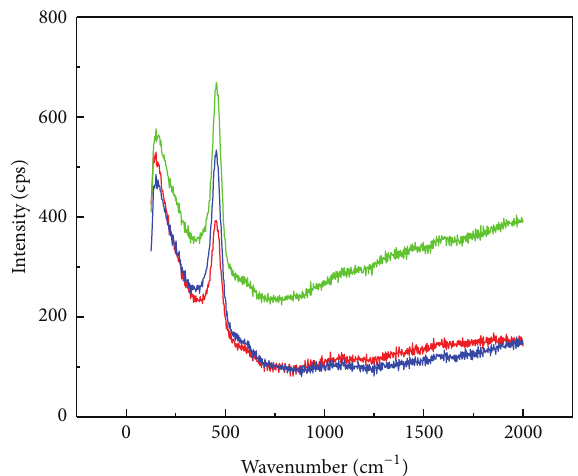
Figure 6: Raman spectra of CeO 2 anodically electrodeposited on stainless steel by galvanostatic mode: j = − 0.06 mA/cm 2 , T = 70 ∘ C.